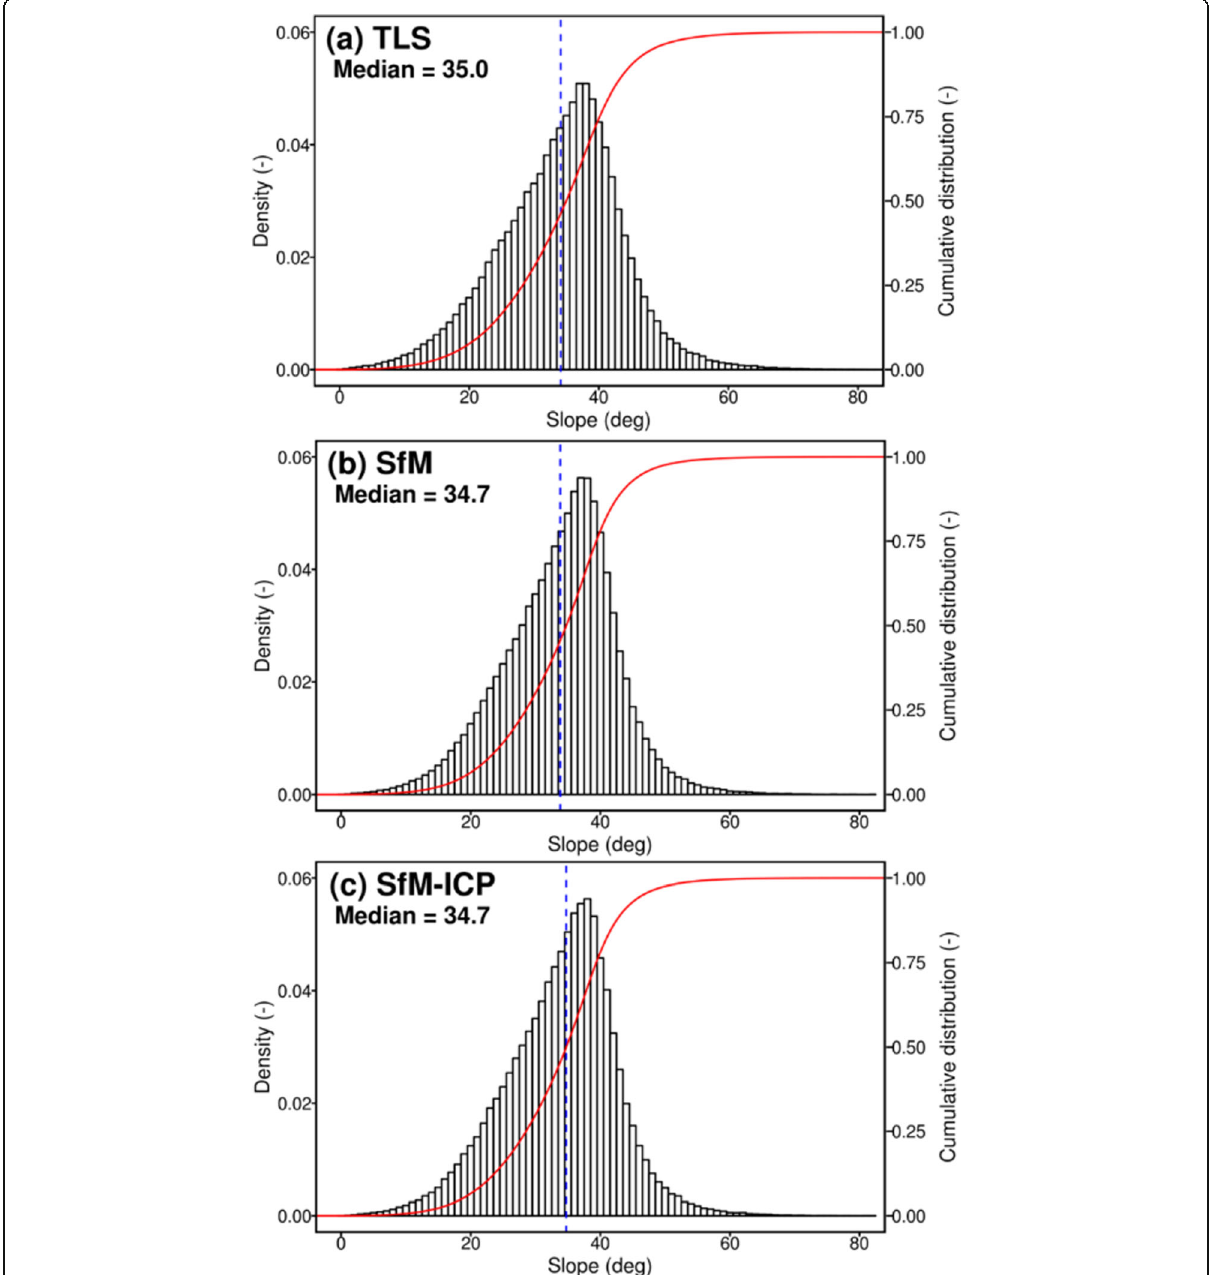
Fig. 9 Histograms of the surface slope in the vicinity of the channel deposits. a DEM TLS . b DEM SfM . c DEM SfM-ICP . Similar to Fig. 4, the red line and dashed blue line indicate the cumulative distribution and the median value,